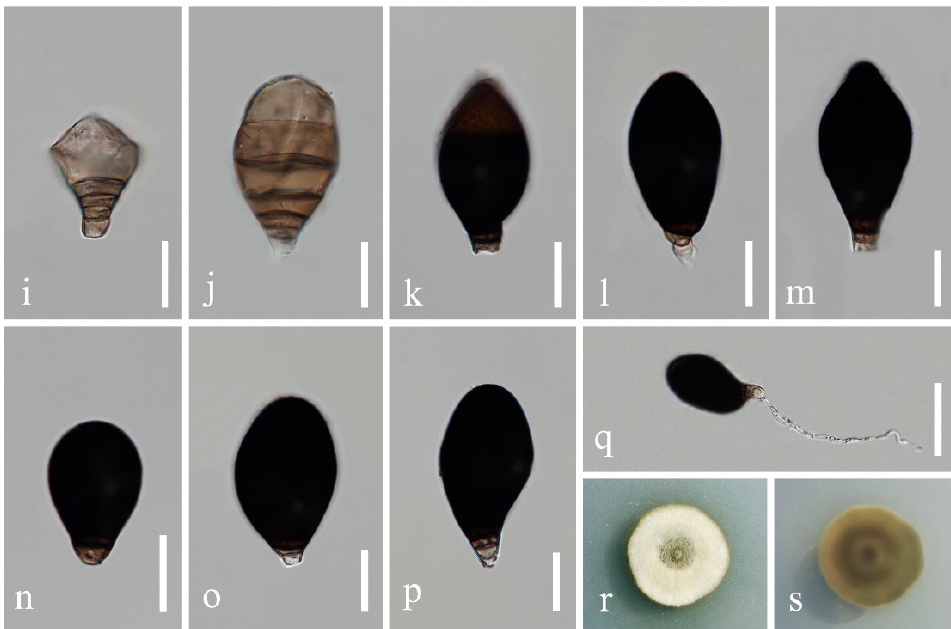
Figure 5. Neoascotaiwania guizhouensis (HKAS 122796, holotype). ( a − c ) Colonies on submerged wood. ( d − h ) Conidiophores with conidia. ( i − p ) Conidia. ( q ) Germinated conidium. ( r , s ) Colony on PDA (( r ) from above, s from below). Scale bars: ( d ) = 40 μ m, ( e − p ) = 20 μ m, ( q ) = 40 μ m.